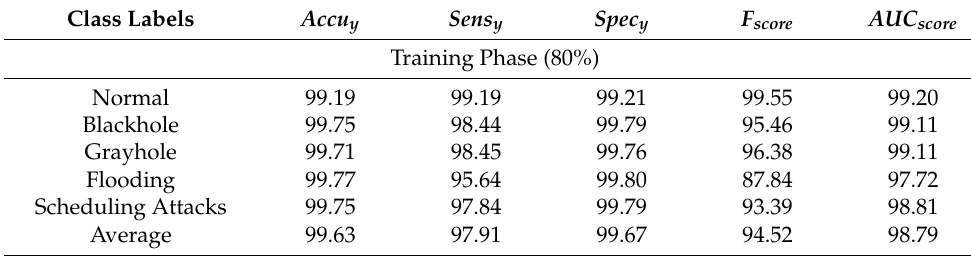
Table 2. Classifier outcome of the BCOA-MLID approach on TRP/TSP of